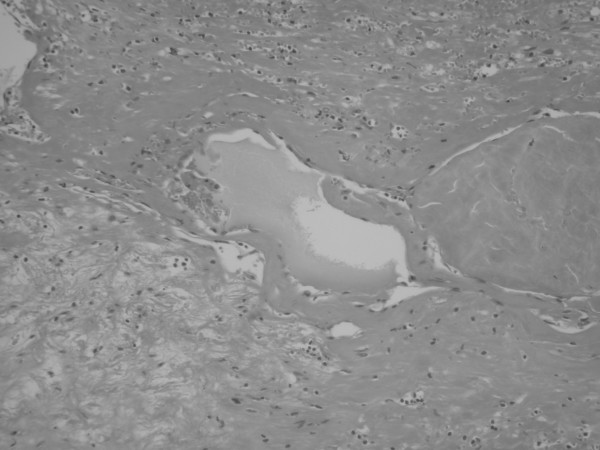
Pathology highlighted results. Cavernous splenic hemangioma: multiple blood-filled spaces (lakes), with flat endothelial cells and areas of hematoma.